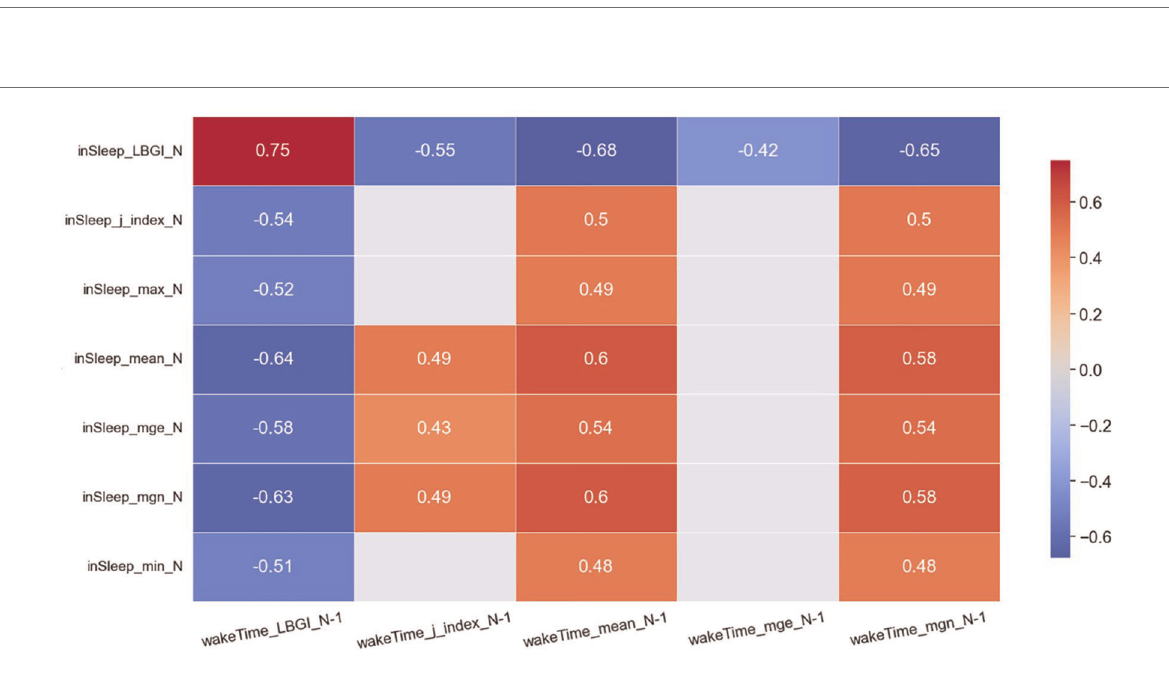
FIGURE 2 Heatmap of signi fi cant correlations between in sleep GV metrics of day N and awake time GV metrics of day N − 1. Only moderate (0.4< rmcor ≤ 0.6) to strong correlations ( rmcor >0.6) are